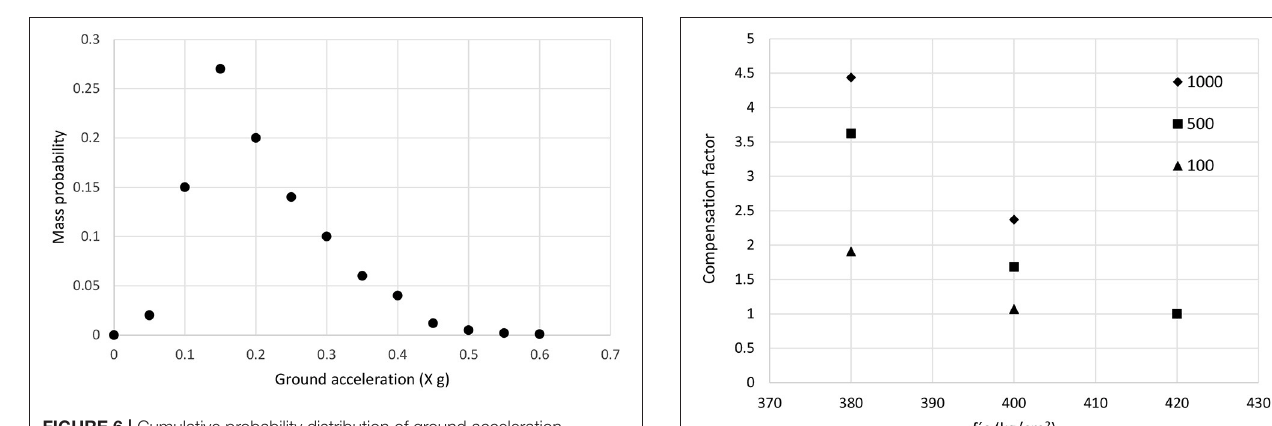
FIGURE 6 | Cumulative probability distribution of ground acceleration. TABLE 2 | Scenario seismic ground accelerations and occurrence probabilities.